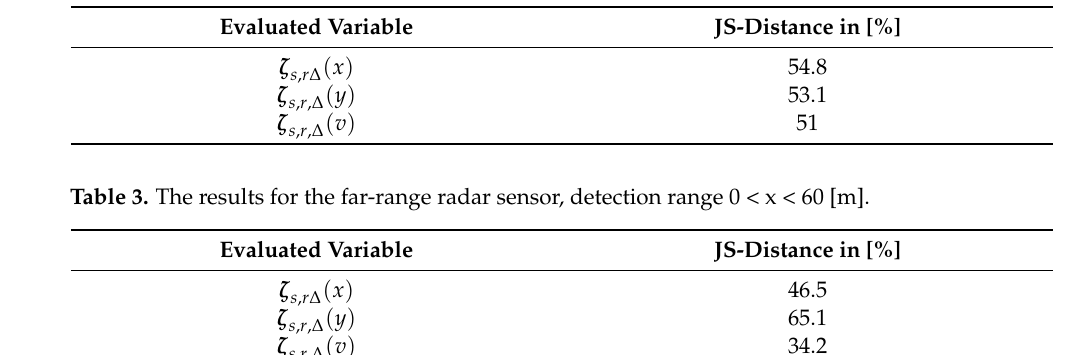
Table 2. The results for the near-range radar sensor, detection range 0 < x < 60 [m].